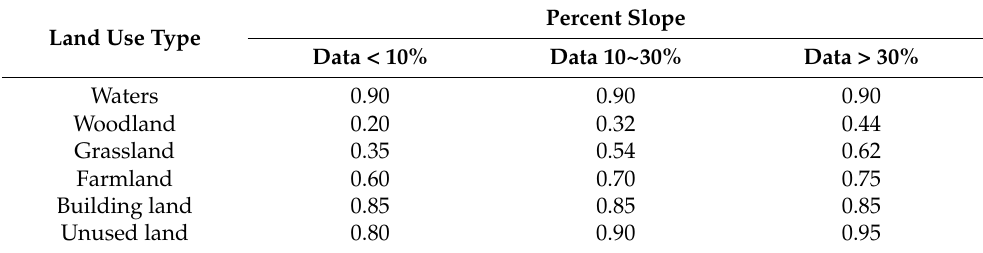
Table 2. Surface runoff